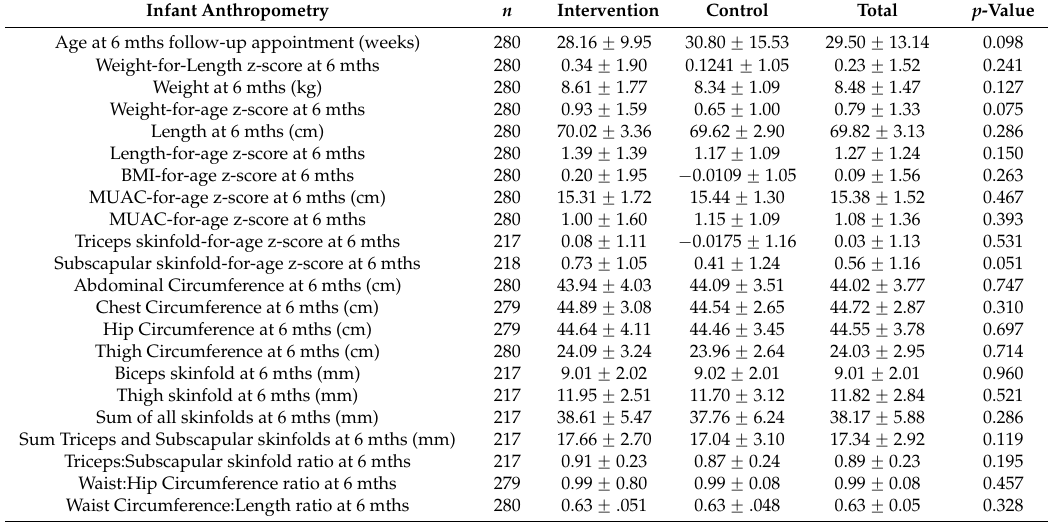
Table 2. 6 months infant anthropometry and comparison of control and intervention (low glycaemic index diet) groups.